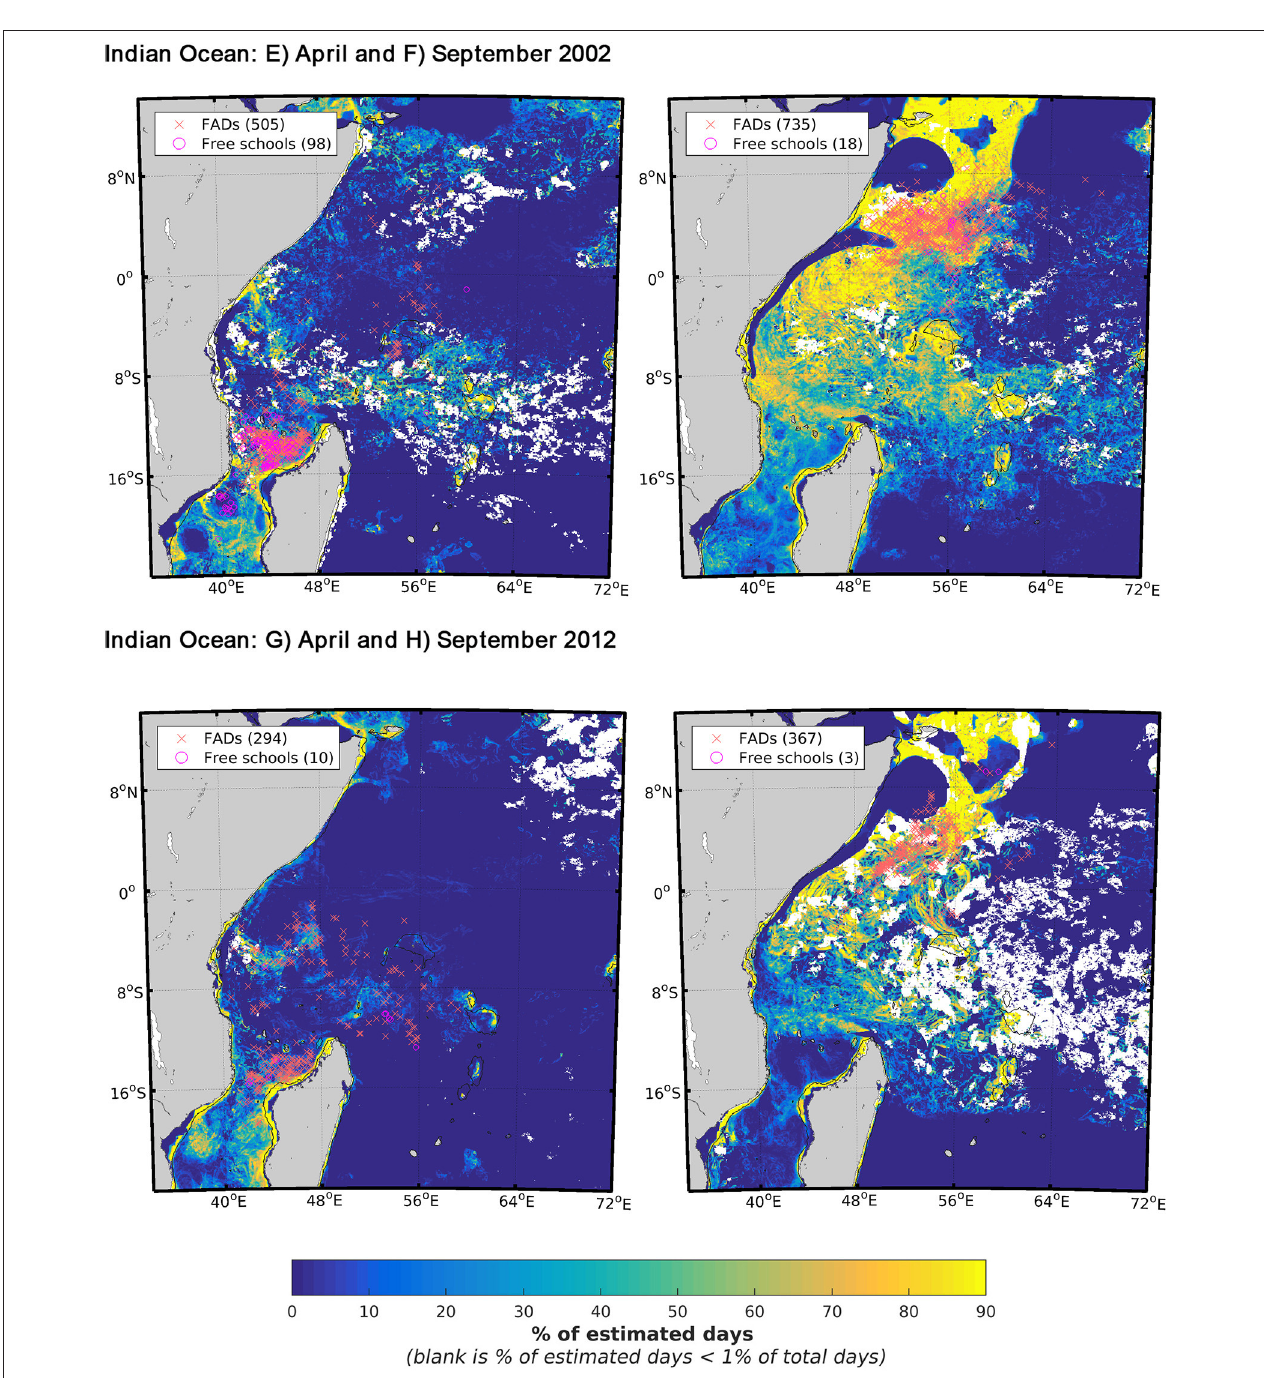
FIGURE 3 | Seasonal favorable feeding habitat and fishing activity defined by presence fishing sets on skipjack tuna ( Katsuwonus pelamis ) in the Eastern Central Atlantic between (A) November and January 2002–2003, (B) July and September 2003, (C) November and January 2012–2013, (D) July and September 2013 and in the Western Indian Ocean between (E,F) April and September 2002 and (G,H) 2012. The drifting fish aggregating device associated sets (dFAD) presence data (red crosses) and the free-swimming school sets (pink circles) were overlaid with their respective numbers of presence data. The monthly ranges and years presented in these figures were chosen specifically to show stark contrasts in terms of fishing mode and habitat size i.e., small (A,C,E,G) vs. large (B,D,F,H) . Favorable feeding habitat is defined by the presence of favorable environmental variable values and expressed as a frequency of occurrence. The blank areas correspond to habitat coverage below 1% of the total number of days in the considered time